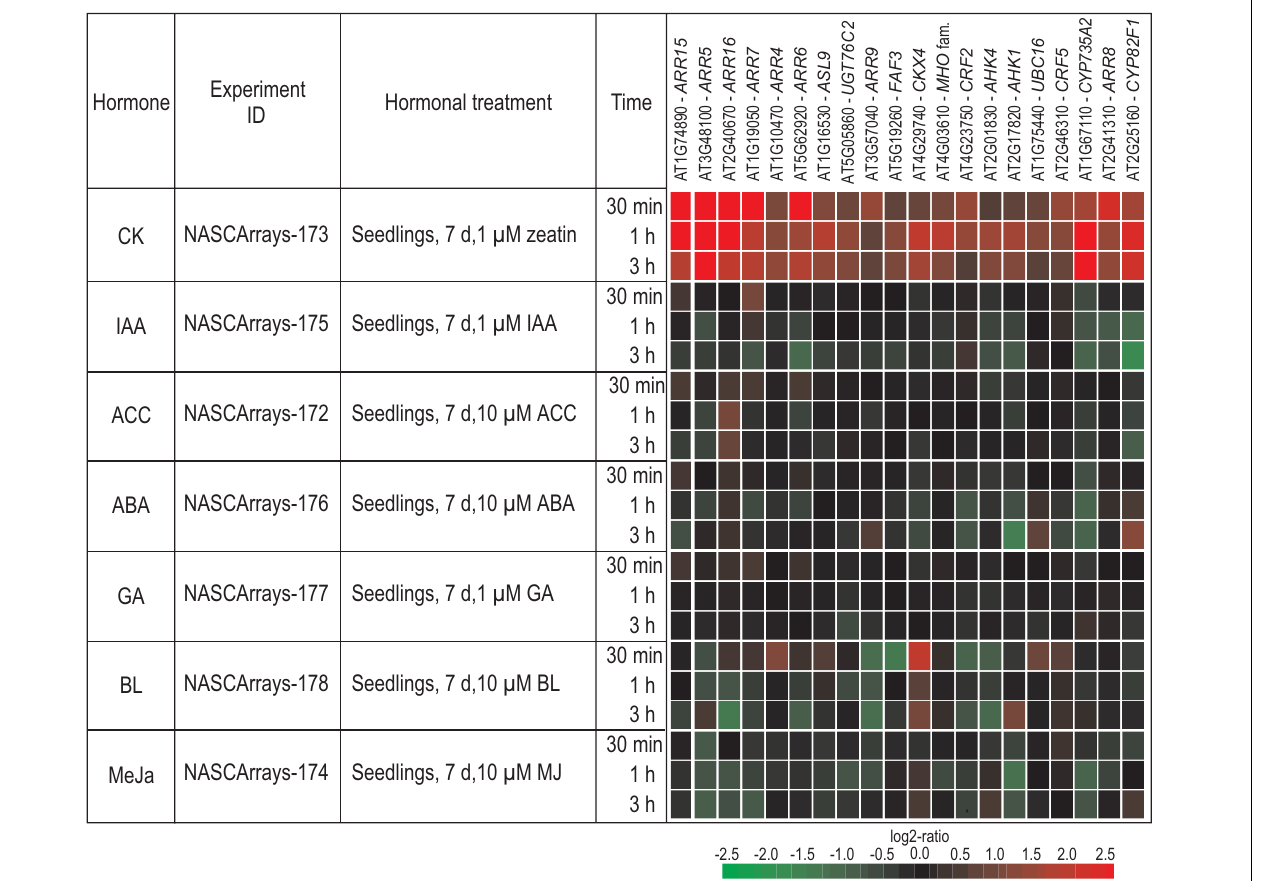
FIGURE 3 | Regulation of cytokinin response genes by different hormones. The hormonal meta-profile analysis of the top 20 cytokinin response genes (see Table 2 ) was established using the Genevestigator database (http://www.genevestigator.com/gv/index.jsp; Hruz et al., 2008) and modified. Only the hormone experiments described by Goda et al. (2008) were considered as tissues (i.e., seedlings); time points and other experimental conditions were most similar to those used for the cytokinin treatments.The gene expression responses are calculated as ratios between